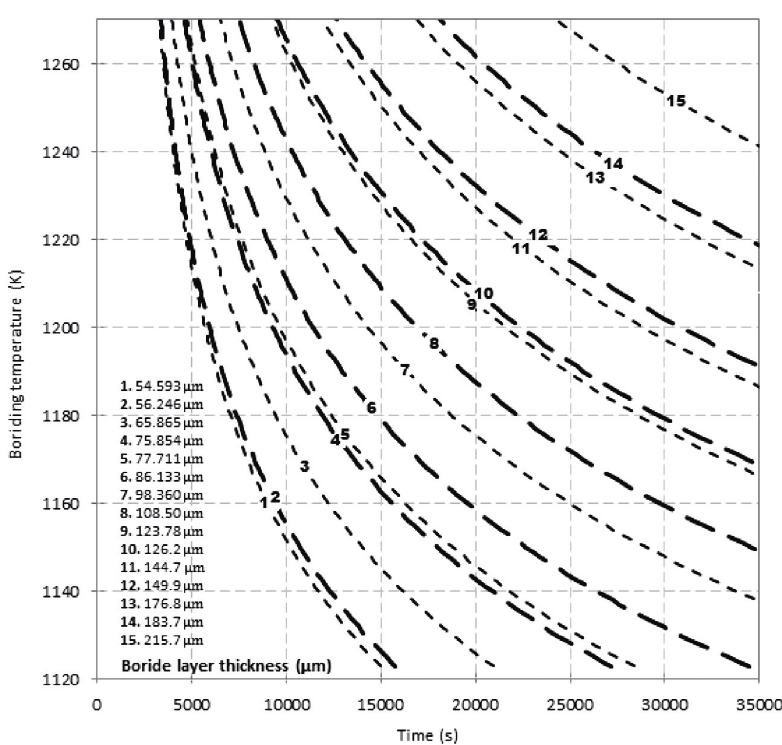
The model was validated by comparing the experi- mental Fe B layer thickness with the predicted one for 2 the sample borided at 1253 K for 5 h. A good agree- ment was observed for these two set of data. A Contour plot relating the boride layer thickness to the boriding parameters (time and temperature) was proposed for practical utilization of this kind of steel. This contour diagram can be used as a tool to select the optimum value of Fe B layer thickness. 2